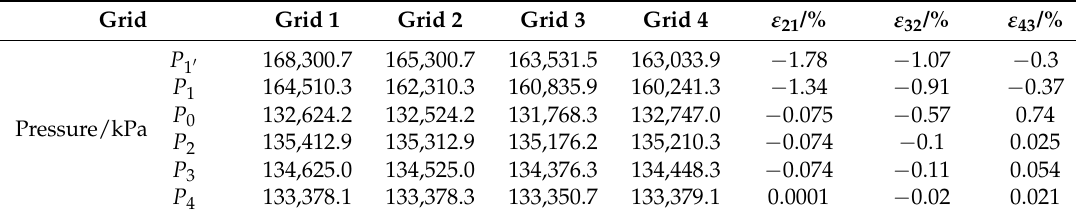
Figure 6. Wall pressure profiles under different grids. Table 5 . Wall pressure and its changes with different grids. Table 5. Wall pressure and its changes with different grids.